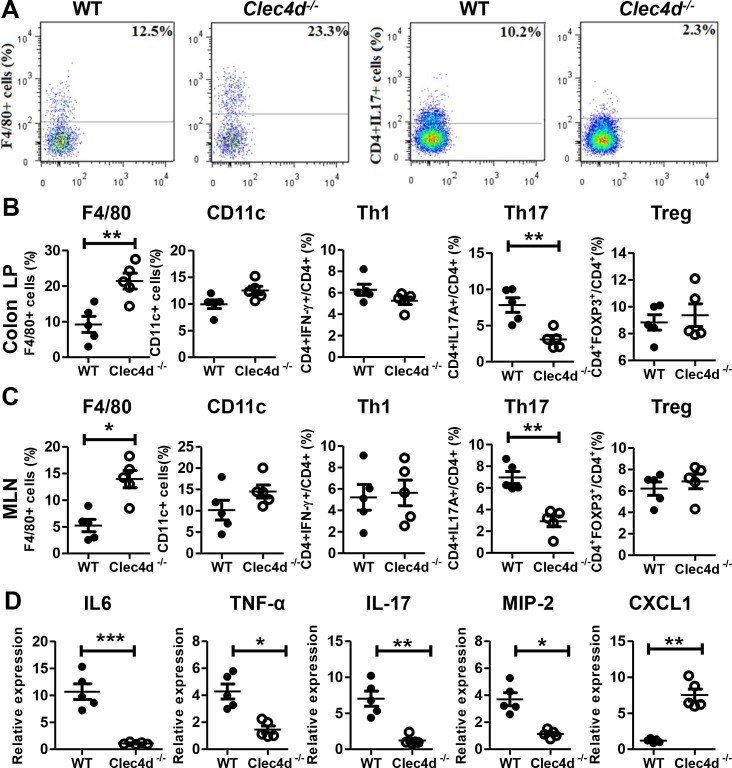
Dectin-3-deficient mice showed impaired immune responses after DSS administration.WT and Clec4d
−/− mice (n = 5 per group) were treated as described in Fig 1. Colonic lamina propria cells and mesenteric lymph nodes cells were separated. (A) Representative image of F4/80+ cells and CD4+IL17+ cells /CD4+ cells in the colonic lamina propria (LP) of WT and Clec4d
−/− mice. (B and C) Frequency of innate and adaptive immune cells including, F4/80+ cells, CD11c+ cells, CD4+IFNγ+ cells/CD4+ cells, CD4+IL17+ cells /CD4+ cells and CD4+CD25+Foxp3+ cells/CD4+ cells were detected in mesenteric lymph nodes (MLN) and colonic LP using flow cytometry. (D) Cytokine expression levels in colonic LP cells were assayed using qPCR. Data represent one of two independent experiments. Error bars, SD. * P<0.05, ** P<0.01, *** P<0.001.